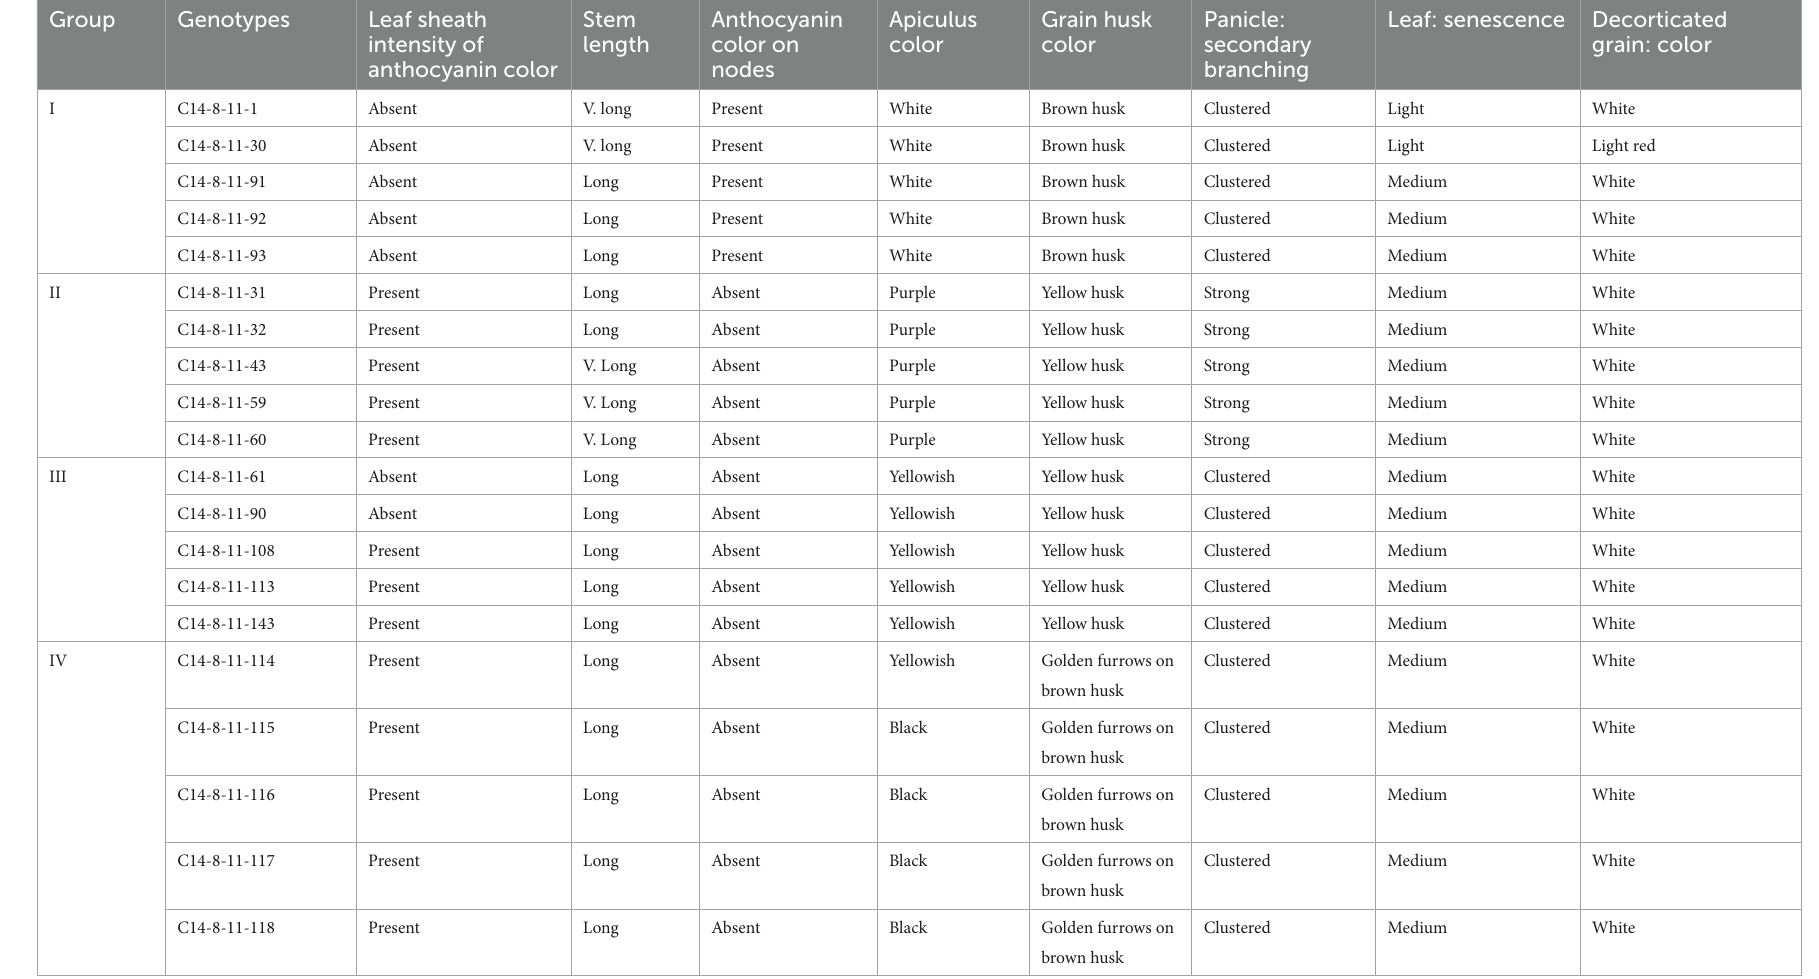
TABLE 1 Morphological descriptors of 20 lines derived from C14-8 rice population * . Group